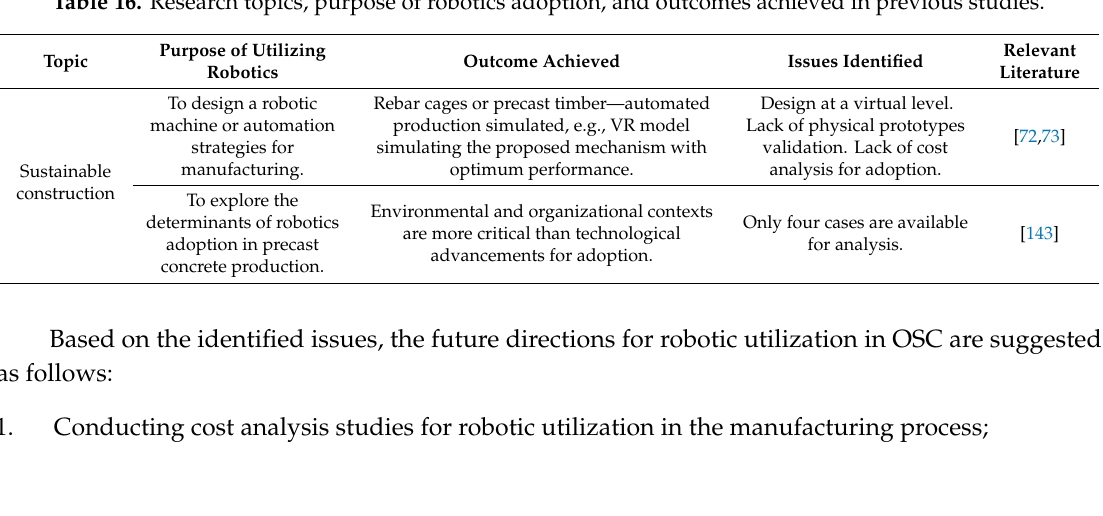
Table 16. Research topics, purpose of robotics adoption, and outcomes achieved in previous